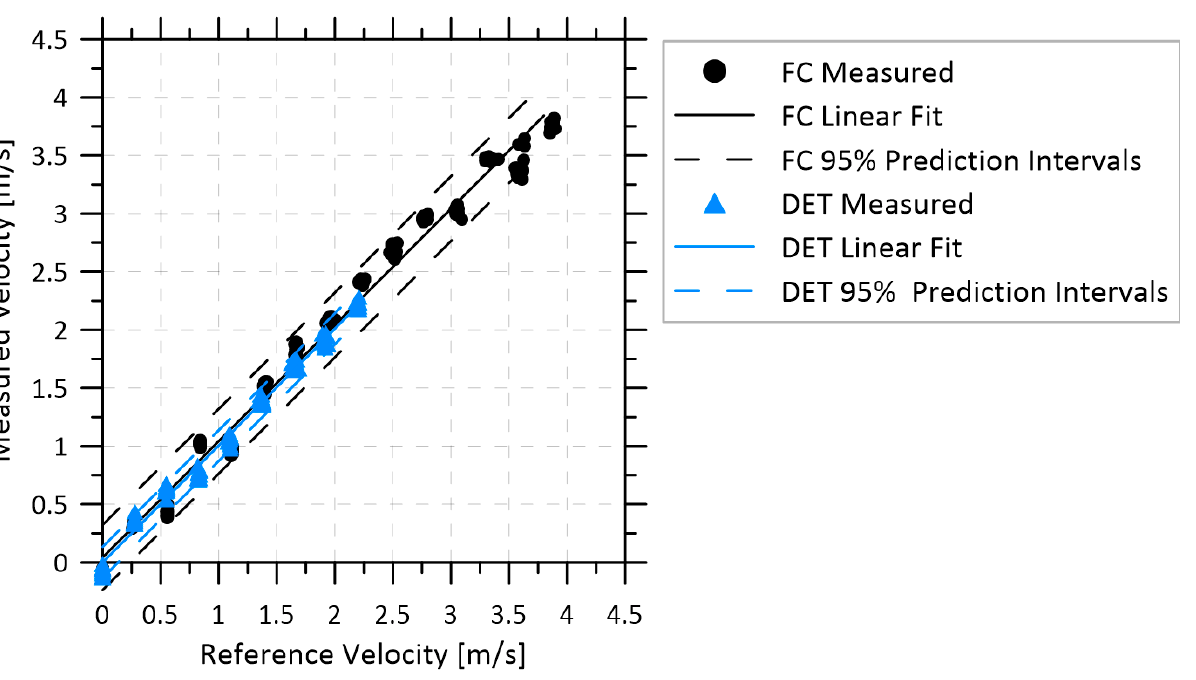
Figure 4. Time ‐ resolved velocity of pure methane compared to set points as reported by mass flow controllers for ( a ) the FC configuration and ( b ) the DET configuration. The lower plots show the measurement error for their respective sequences.